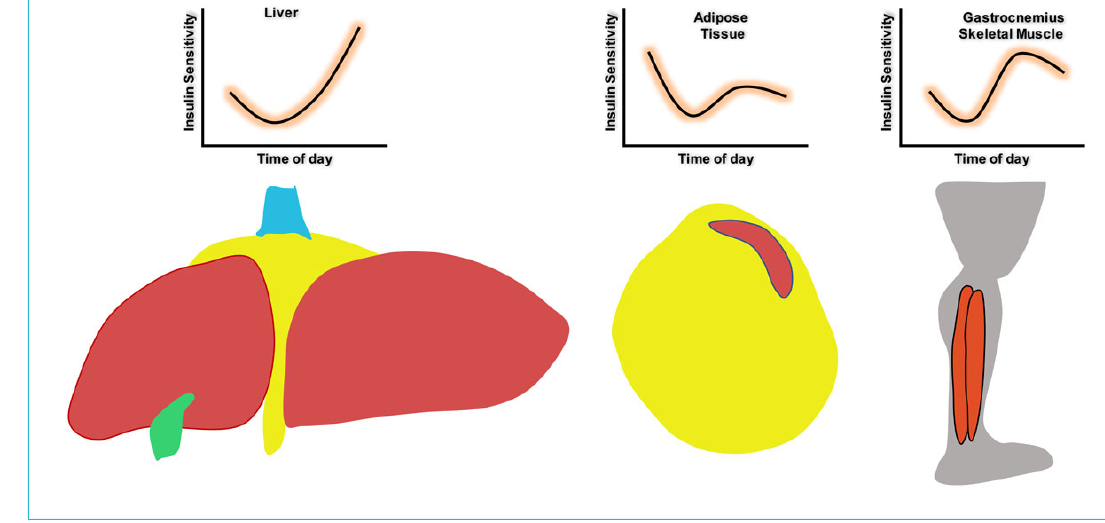
Figure 2: Tissue insulin sensitivity varies around the clock in vivo . Illustrations representing diurnal fluctuations in the insulin sensitivity of liver, adipose tissue and gastrocnemius skeletal muscle, as indicated by Aras et al. [139]. Drawings by Vincenzo Antonio Vianna